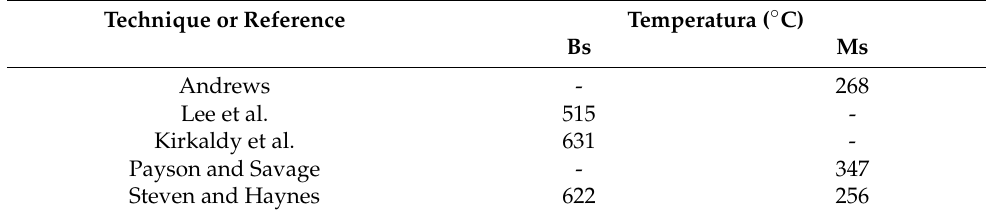
Table 3. Bs and Ms temperatures computed by means of empirical equations [18]. Technique or